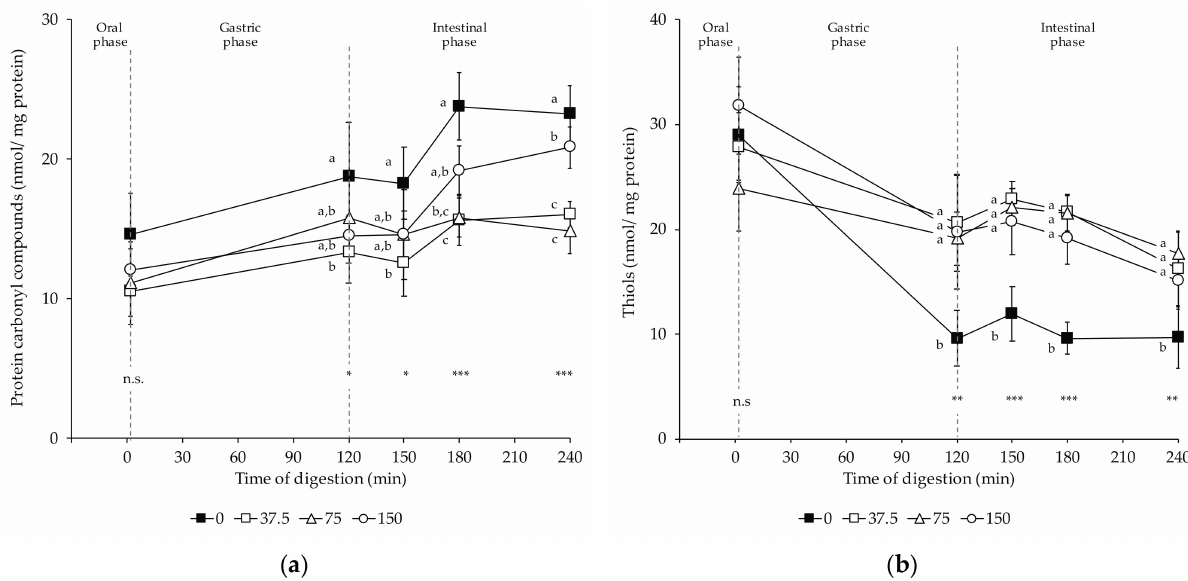
Figure 5. Changes in protein oxidation products in dry-cured loins formulated with different amounts of NO 2 Na/NO 3 K (0, 37.5, 75, and 150 mg/kg) during in vitro gastrointestinal digestion: ( a ) protein carbonyls; ( b ) thiols. The time 2 min represents the end of the oral phase, time 120 min, the end of the gastric phase; meanwhile, times 150 and 180 min represent intermediate times of the intestinal phase that ends at time 240 min. *: p < 0.05; **: p < 0.01; ***: p < 0.001. a,b: Means for the same time of sampling with different letters are significantly different ( p ≤ 0.05, Tukey’s